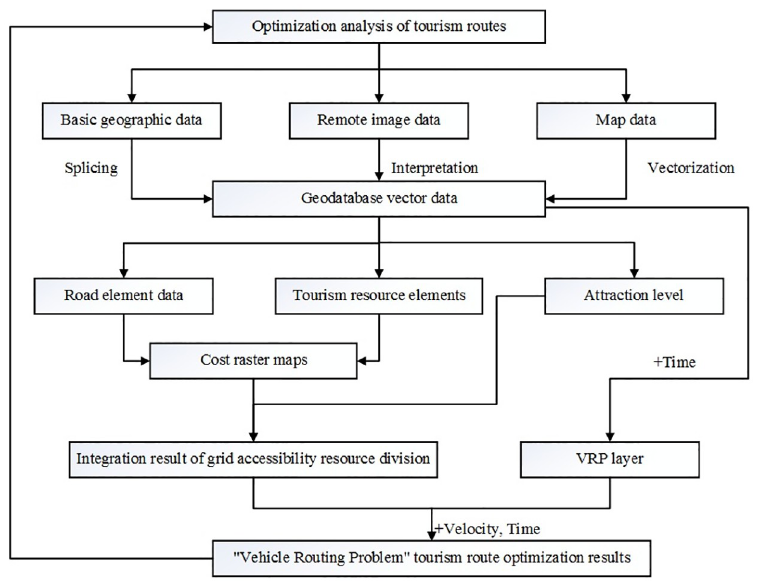
Fig 2. Optimization analysis of tourism routes model flow